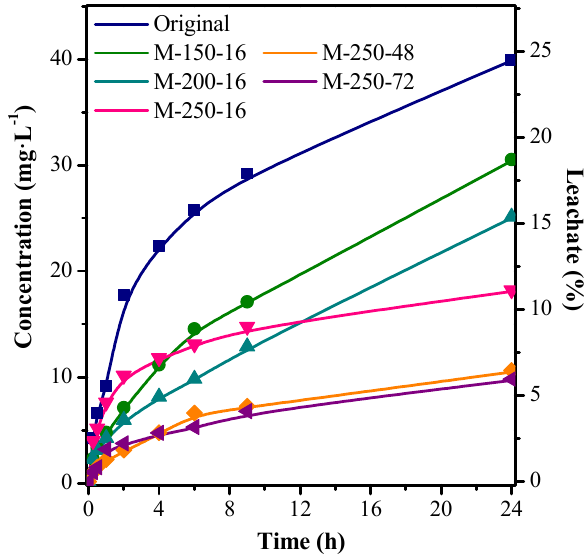
Figure 10. Linker leaching in water from the original NH 2 -MIL-125(Ti) and after heat treatment in air for 16 h at different temperatures and at 250 °C during different times.